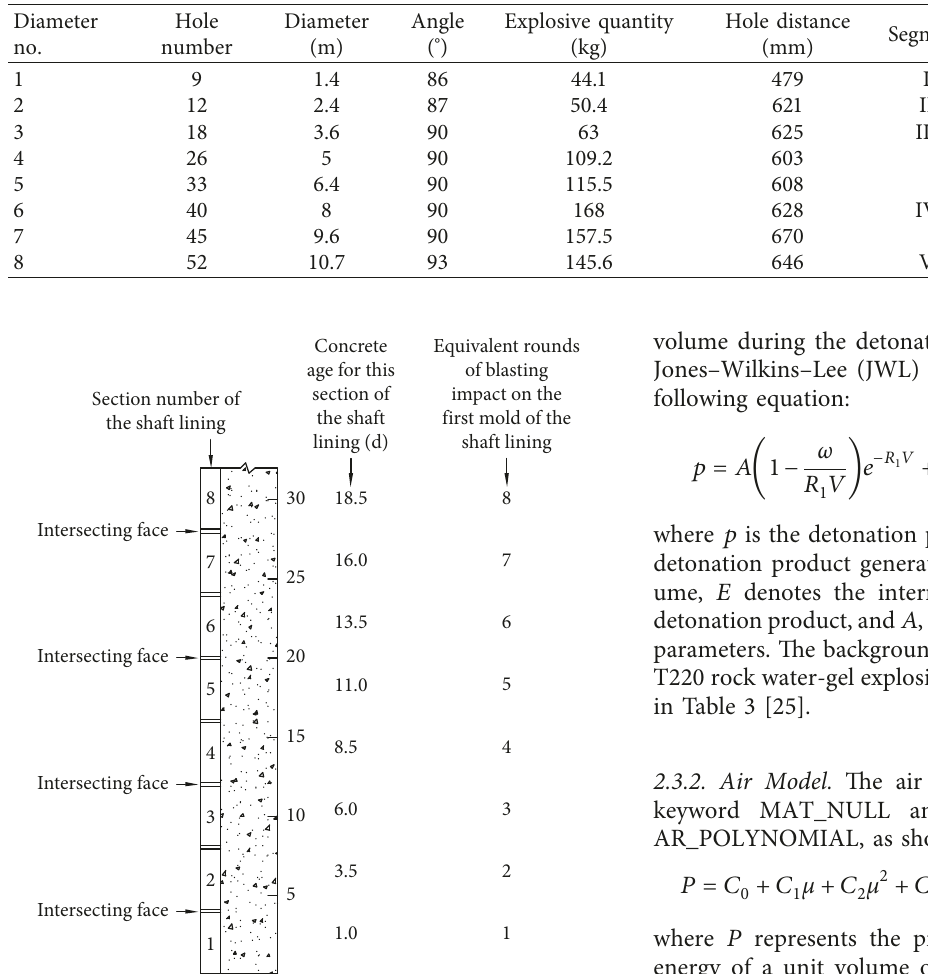
Table 1: Blasting parameters.